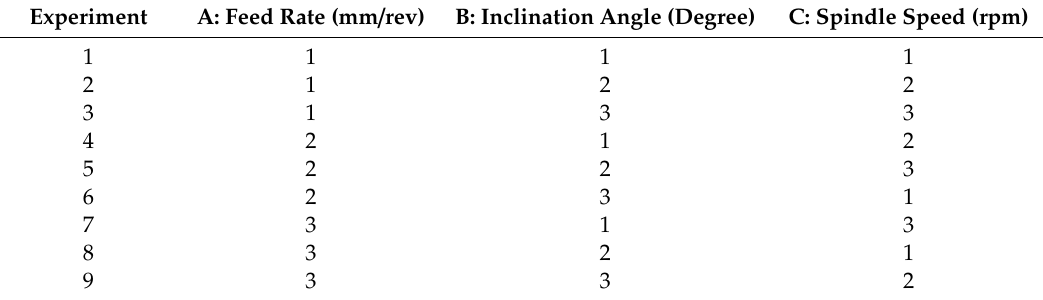
Table 3. Orthogonal Array L9 (3 × 3) experimental Layout